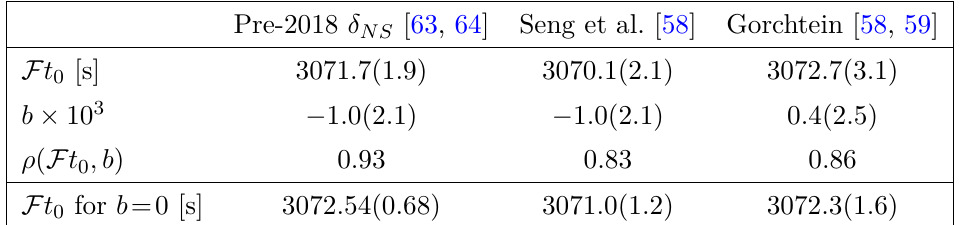
Table 2 . Results of global fits to superallowed 0 + → 0 + transitions using different nuclear-structure dependent corrections. The 2nd column uses standard pre-2018 values [63, 64]. The 3rd column includes the correction pointed out in Seng et al. [58], and the 4th column adds Gorchtein [59] as well. We find χ 2 /dof ∼ 0 . 5 for all cases. ρ gives the correlation between the two free parameters min of the fit. The last row shows the result in the absence of a Fierz term b